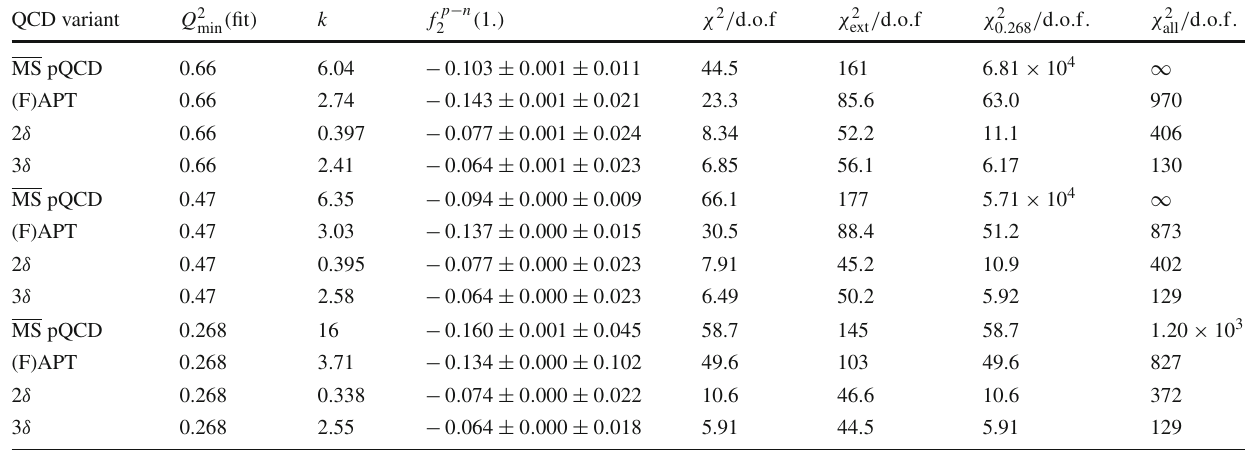
Table 1 The values of the extracted fit parameters k = μ 2 / Q 2 and − n ( Q 2 ) ( Q 2 = 1 GeV 2 ), obtained by fitting the OPE expression f p in in 2 (10), truncated at D = 2 ( μ 6 = 0), for the considered four QCD vari- ants, and for the minimal Q 2 values of the fit being 0 . 66, 0 . 47